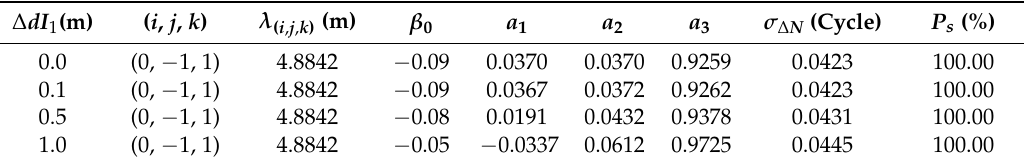
Table 2. Optimal BDS triple-frequency code-phase combinations and the corresponding AR success rate for different code noises and ionosphere residuals.